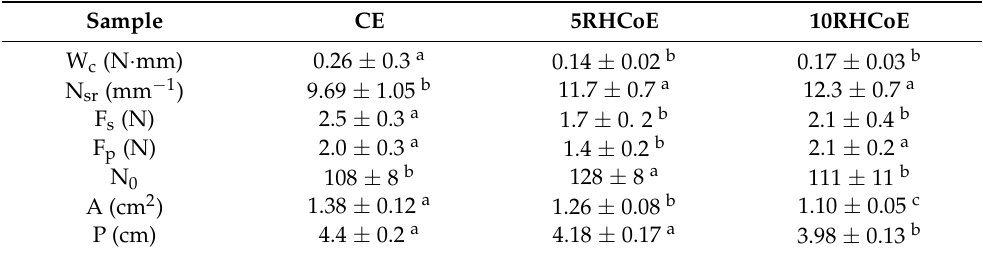
Table 3. C rispness work (W c ), spatial frequency of structural ruptures (N sr ), average specific force of structural ruptures (F s ), average puncturing force (F p ), and number of peaks (N 0 ) of extrudates from